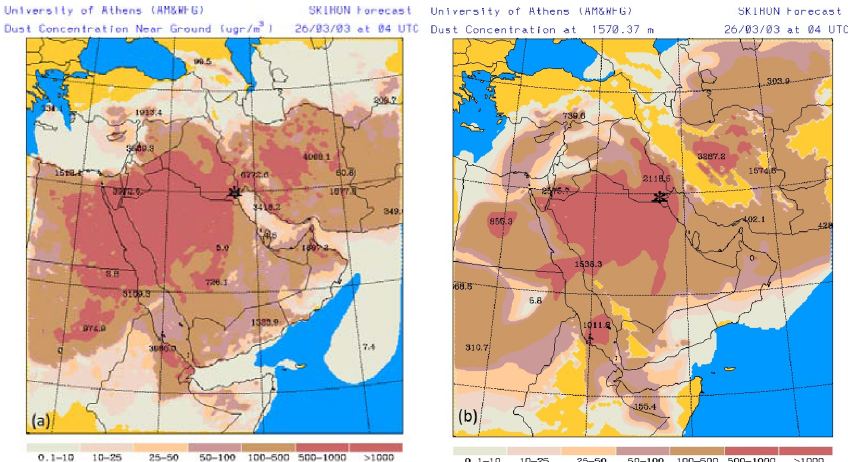
Fig. 11. Dust concentration (µm − 3 ) on 26 March for near-ground level (a) , and at an elevation of 1570m from ground level (b) . The ∗ indicates Kuwait’s location.